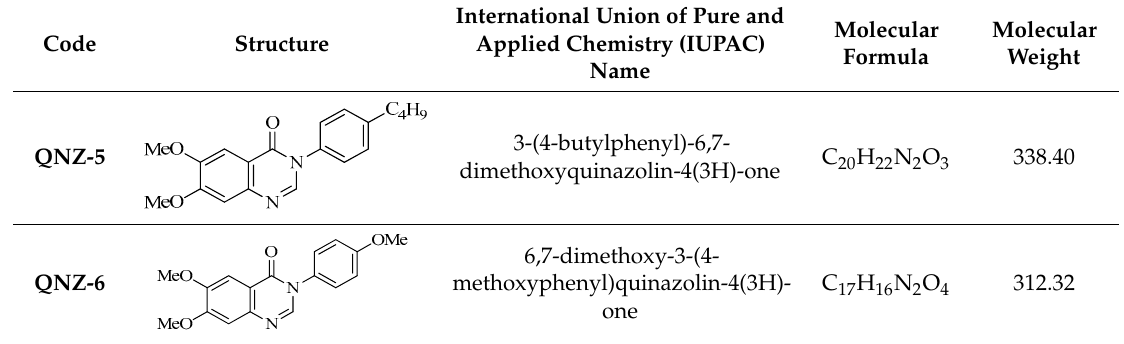
Table 2. The chemical definitions of six quinazolinone derivatives. Code